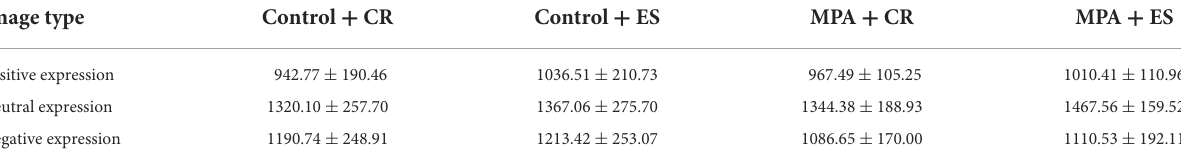
TABLE 1 The average RTs for different groups.